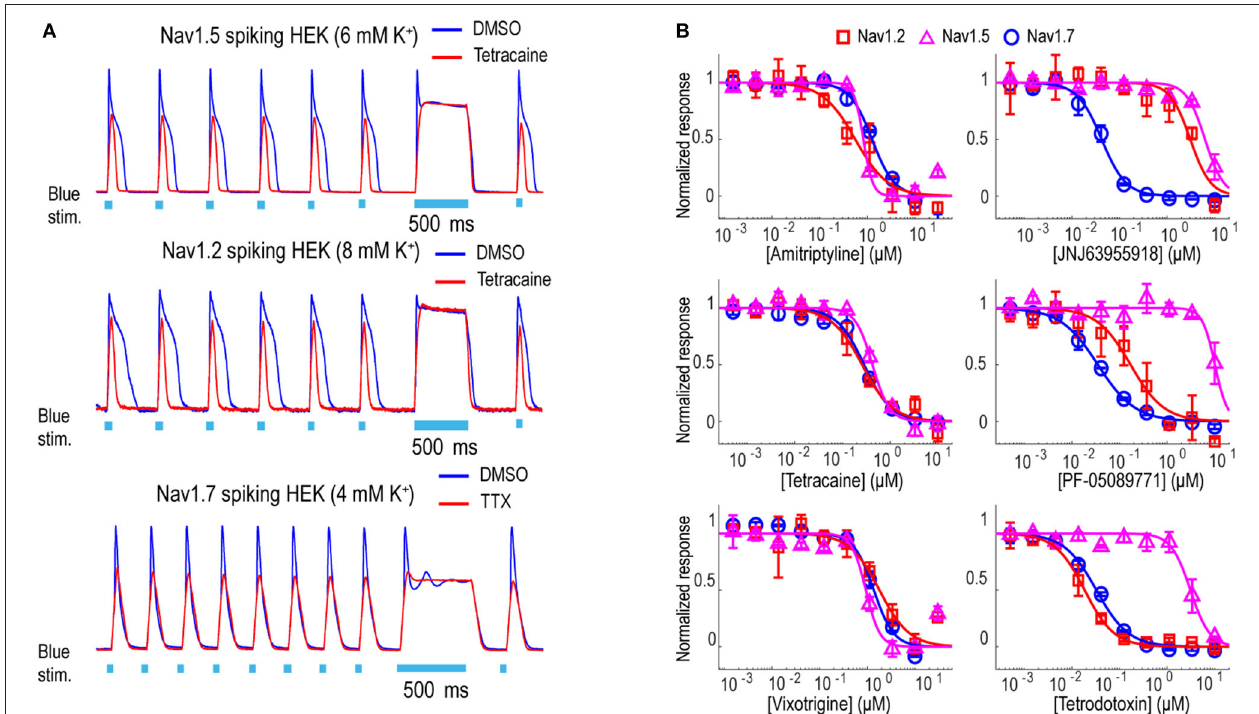
FIGURE 3 | Tool compound concentration-response curves on different Nav channel subtypes. (A) Representative fluorescence traces from DMSO, 1 µ M TTX, or 10 µ M tetracaine treated Nav1.2 spiking HEK cells (8mM bath [K + ]), Nav1.5 spiking HEK cells (6mM bath [K + ]), and Nav1.7 spiking HEK cells (4mM bath [K + ]). For Nav1.2 and Nav1.5 spiking HEK assays, the cells were stimulated at 2Hz. Eight test pulses were applied before the 500ms long pulse and only action potentials triggered by the third to the eighth pulses were plotted for these two Nav channel subtypes; for Nav1.7 spiking HEK cells, the cells were stimulated at 4Hz and all 10 triggered action potentials are plotted. (B) Concentration-response curves of 3 non-selective Nav channel blockers (Amitriptyline, Tetracaine, Vixotrigine) and 3 subtype-selective Nav channel blockers (JNJ63955918, PF-05089771, Tetrodotoxin) on Nav1.2 (8mM bath [K + ]), Nav1.5 (6mM bath [K + ]), and Nav1.7 (8mM bath [K + ]). Error bars indicate SD based on measurements from 2